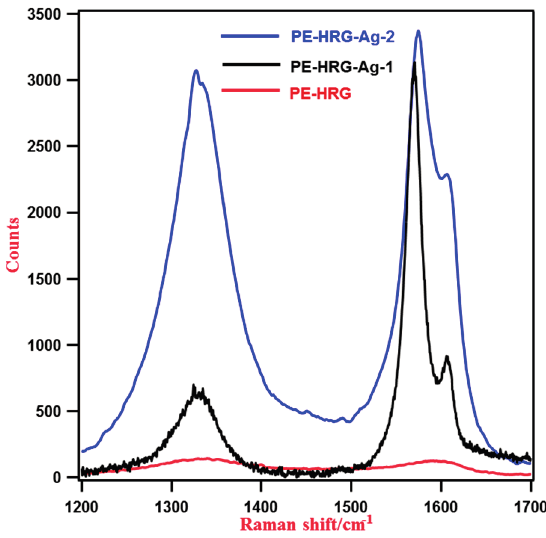
Figure 4. Raman spectra of PE-HRG with and without Ag NPs. With increasing the concentration of Ag NPs the intensities of the Raman signals also